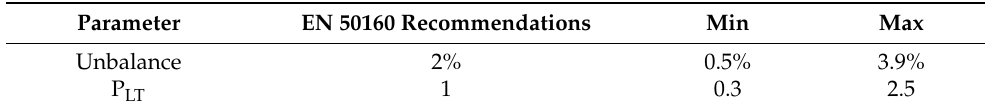
Table 4. Voltage unbalance and flicker measurement results for Object 2.